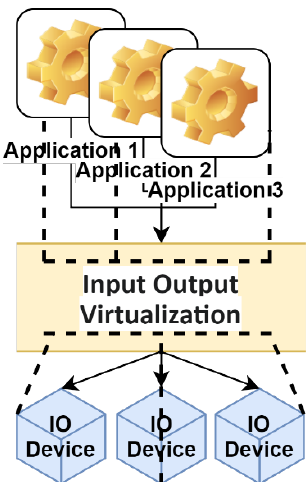
Figure 3. Concept of Virtual Channel in Input Output (I/O) Virtualization.